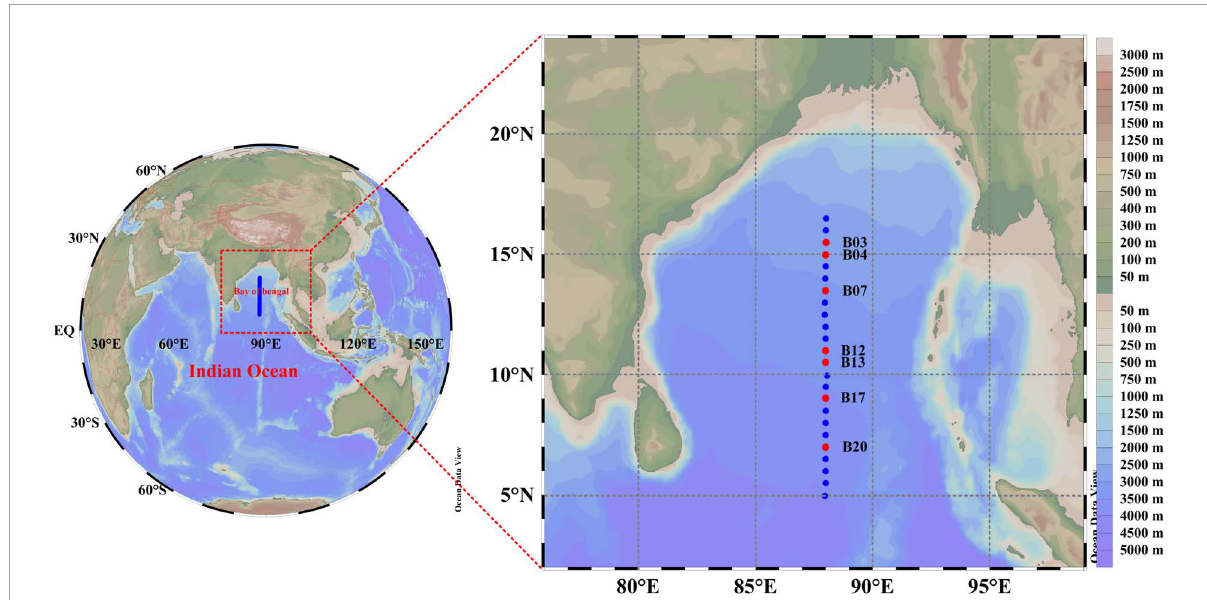
FIGURE1 The map showing the sampling stations in the central BoB. The left miniature map describes the location of the BoB. The blue dots in the right map showing stations used for hydrography measurement, among which red dots represent stations used for the molecular experiment.